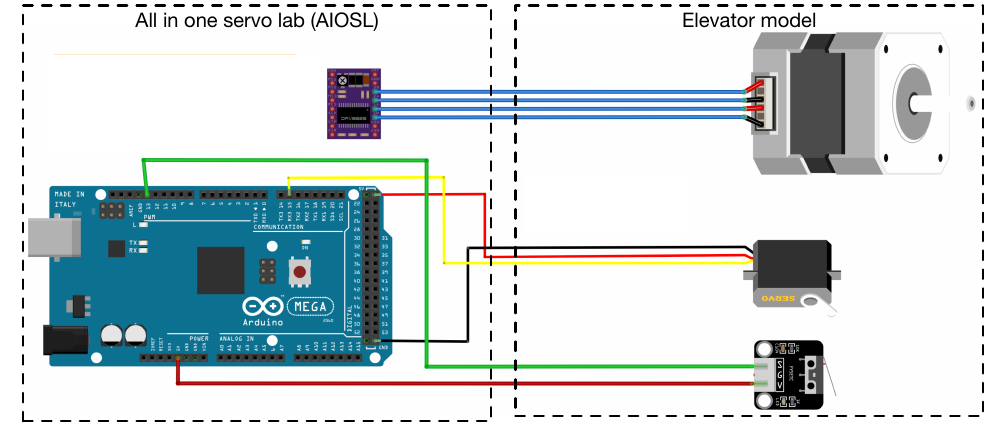
Figure 4. Schematic of the connection from the AIOSL to the elevator model.